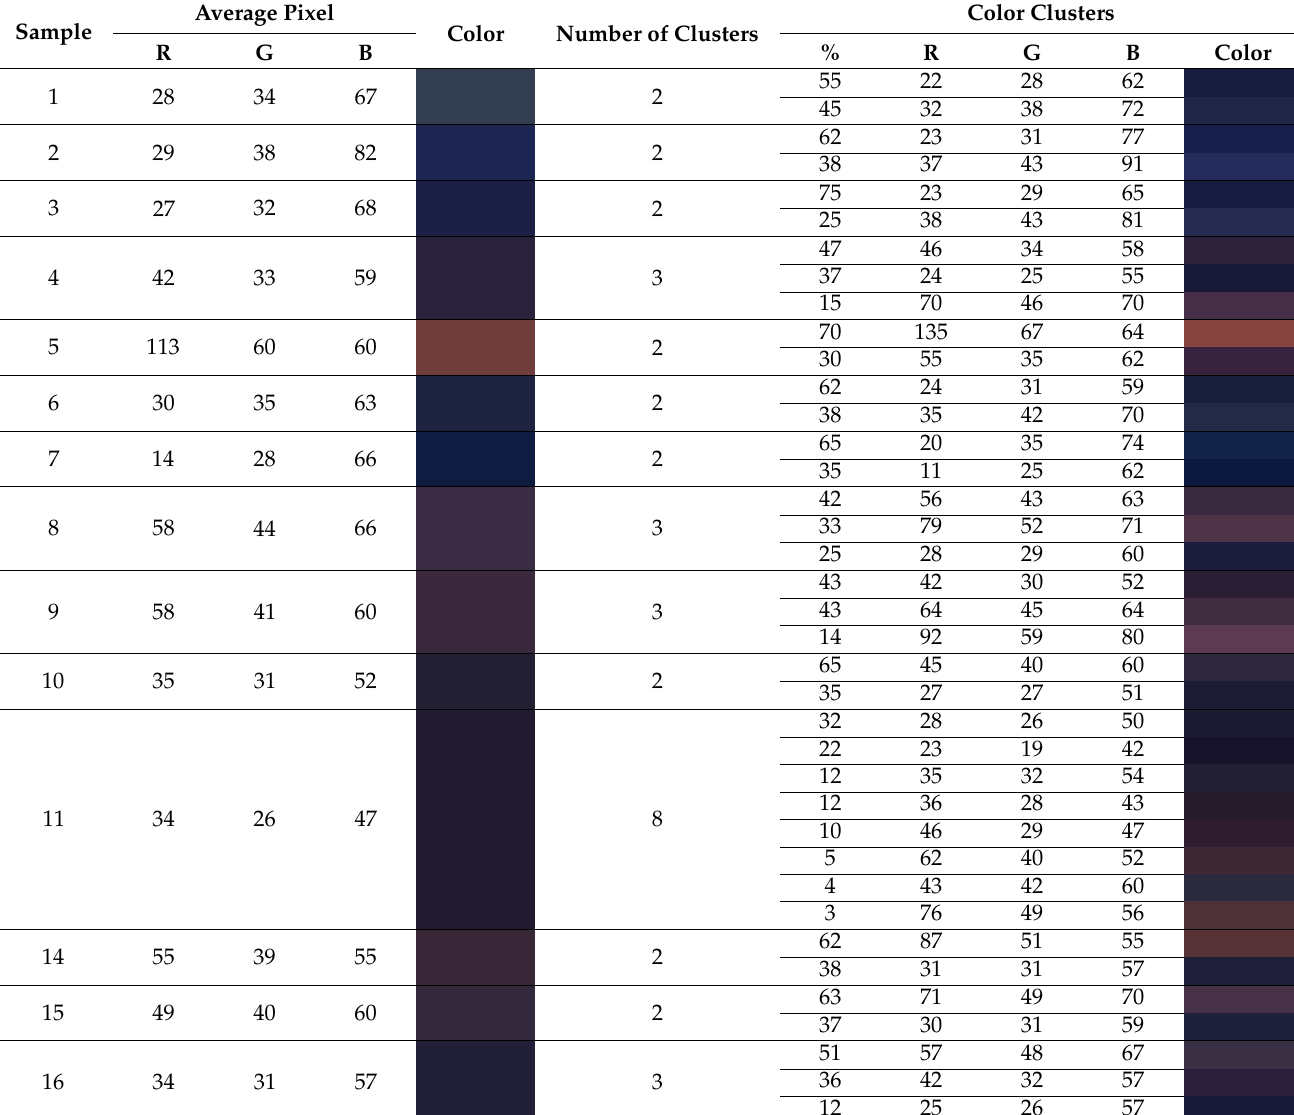
Table 3. RGB color values for the analyzed CL images including the average pixel and the color clusters for the images treated with the CLARA algorithm; the area percentages of the color clusters are also indicated. The actual colors are also